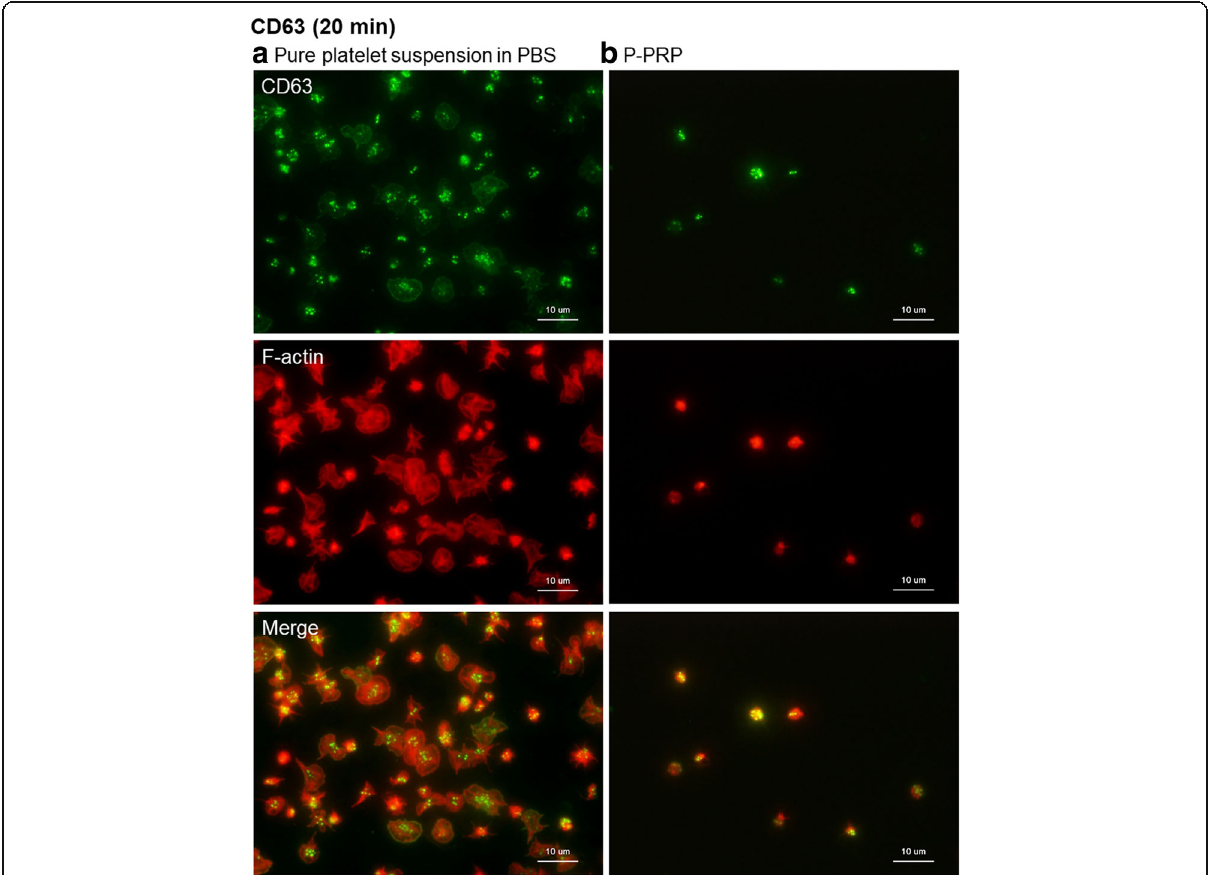
Fig. 10 Expression of CD63 in platelets adhered onto the surface of cp -Ti plates. a Platelets suspended in PBS and b P-PRP. CD63 (green) and F-actin (red) were individually visualized and merged in the bottom panels. cp - Ti commercially pure titanium, PBS phosphate-buffered saline, P - PRP pure platelet-rich